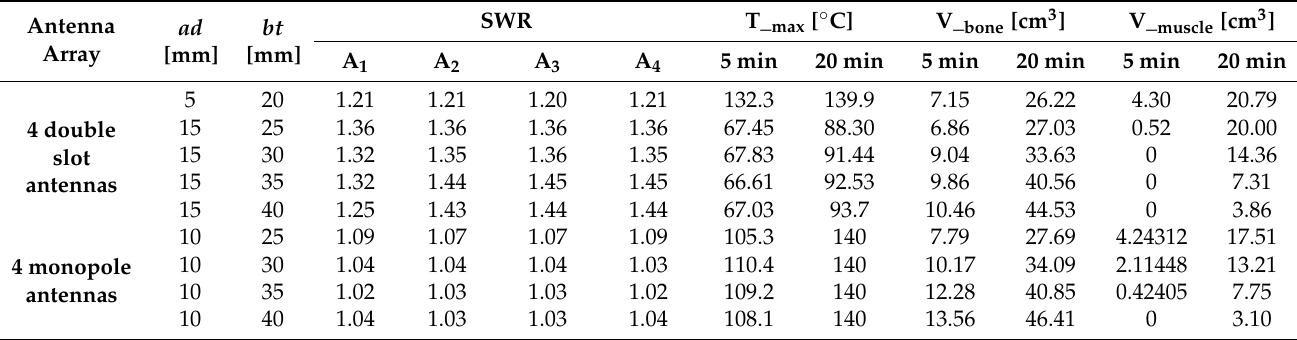
Table 7. Square antenna array performance. Best-case scenarios were obtained for each analyzed bone thickness ( bt ) based on the SWR of the antennas. Maximum reached temperature and tissue volume at temperatures higher than 55 °C are presented.